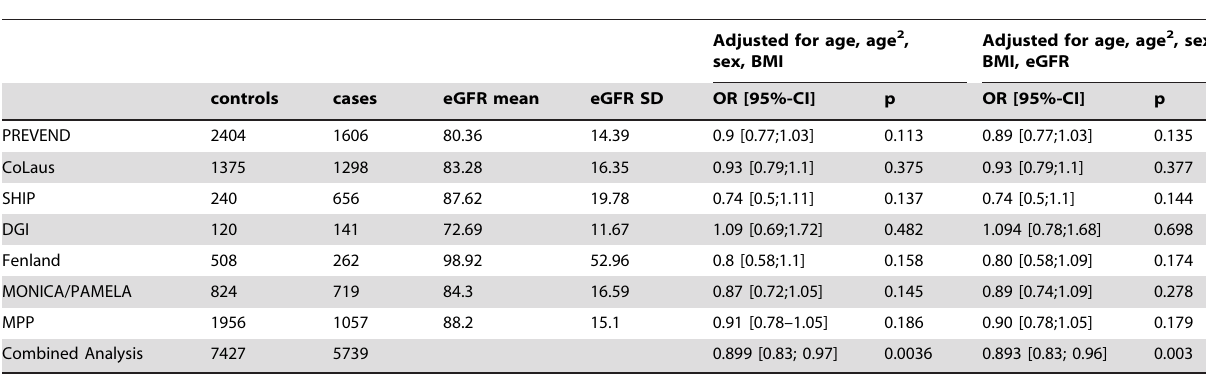
Table 3. Results from the meta-analysis of rs13333226 and HTN before and after adjustment for eGFR.